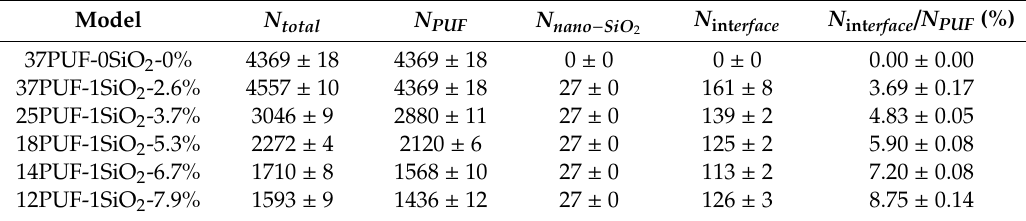
Table 5. The number of hydrogen bonds for PUF-SiO 2 models (mean ± standard error).